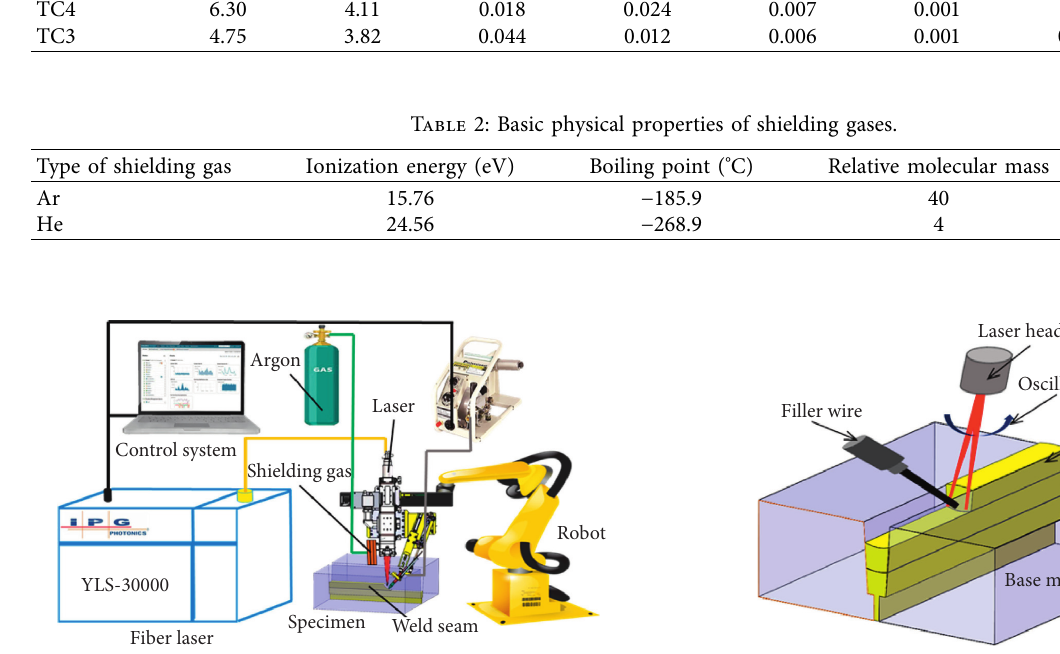
Figure 4: Schematic diagram of welding experimental